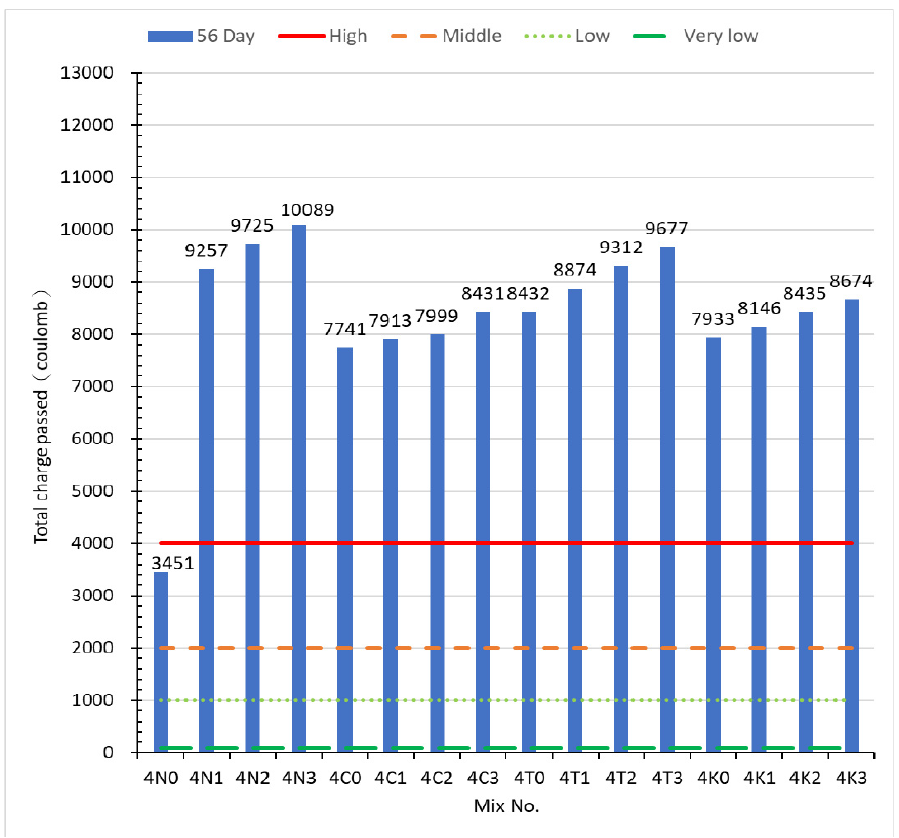
Figure 12. Chloride charge flux of cement mortar when W/C = 0.4.